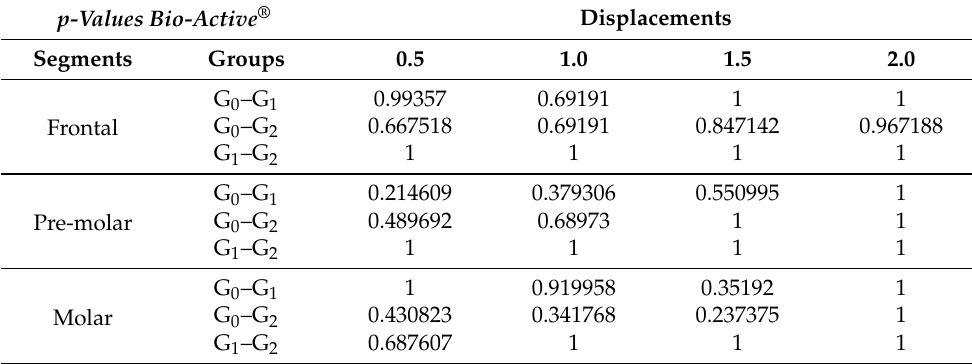
Table 3. Bio-Active ® p -values, resulting from the statistical comparison of each segment in the G 0 , G 1 , G 2 periods of clinical use, at {0.5, 1.0, 1.5, 2.0} mm deformation.